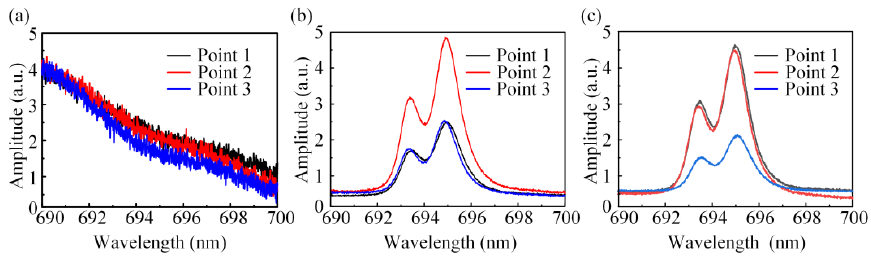
Figure 9. Cr 3+ fluorescence spectra of specimens ( a ) S1, ( b ) S2 and ( c ) S3.